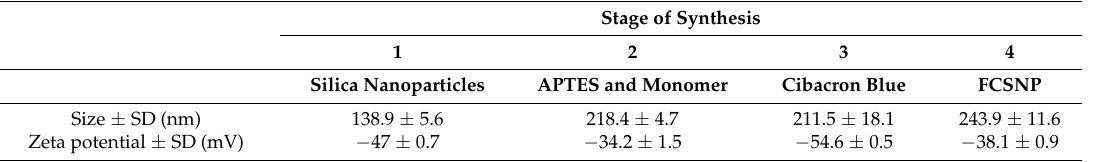
Table 1. Size and zeta potential of the silica nanoparticles at each stage of synthesis. Values are expressed as the mean ± standard deviation (SD) of three samples, each measured in triplicate.